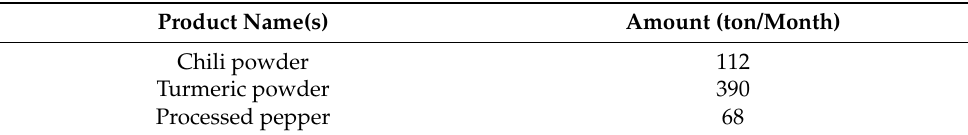
Table 2. List of products of the plant.